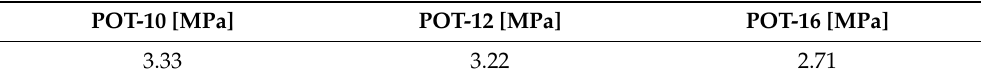
Table 15. Mean value of concrete tensile strength (f ctm ) according to pull-out test series (in MPa). POT-10 [MPa] POT-12 [MPa] POT-16 [MPa]